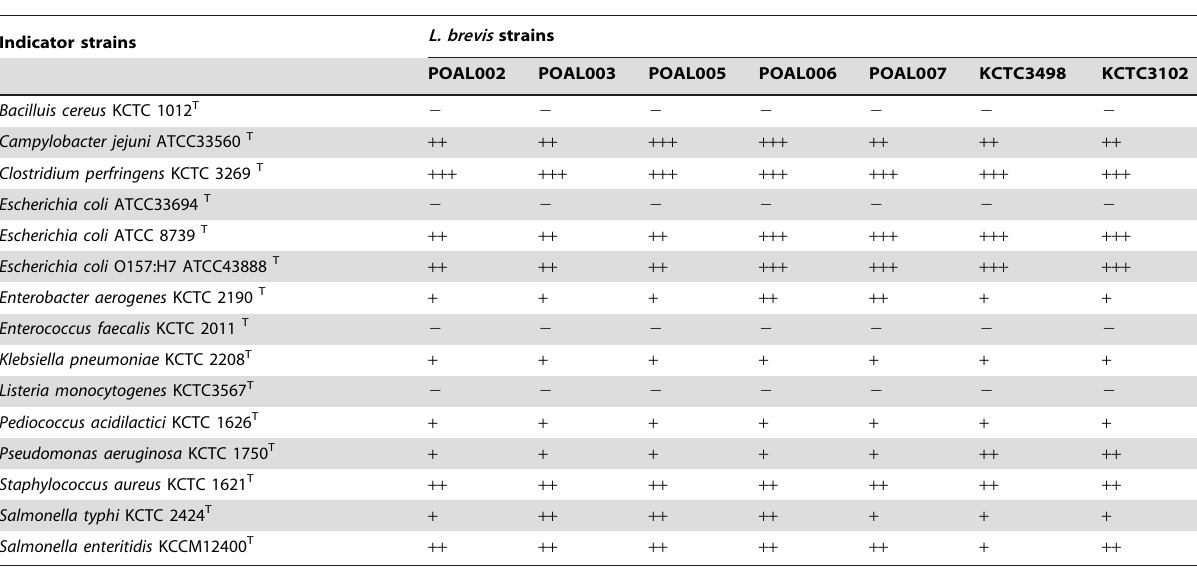
Table 4. Antimicrobial spectrum of the selected L. brevis POAL strains*.